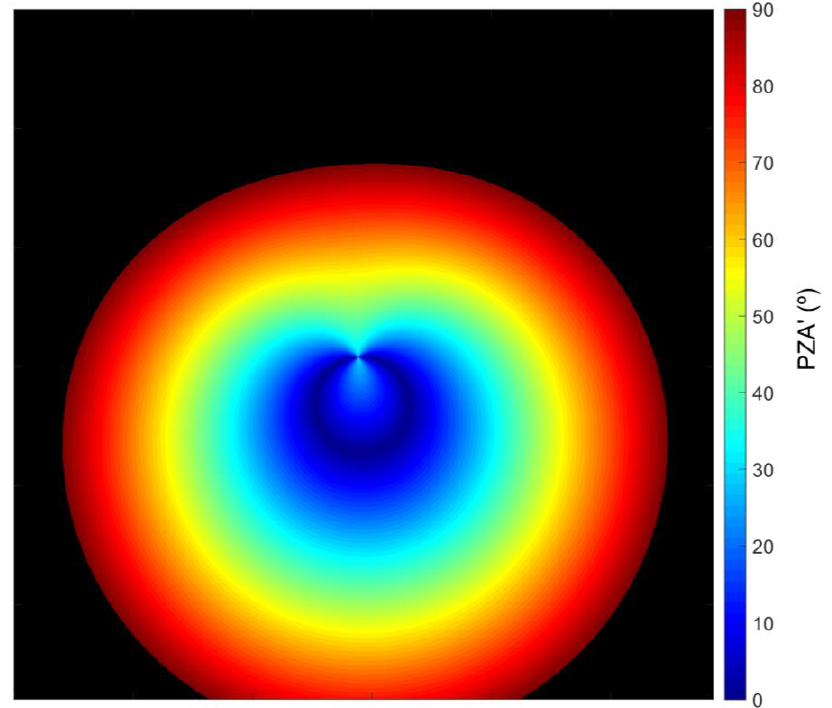
Figure 10. Example of a PZA’ matrix for a tilted plane of 30 ° and oriented to geographical South with an azimuthal misalignment of